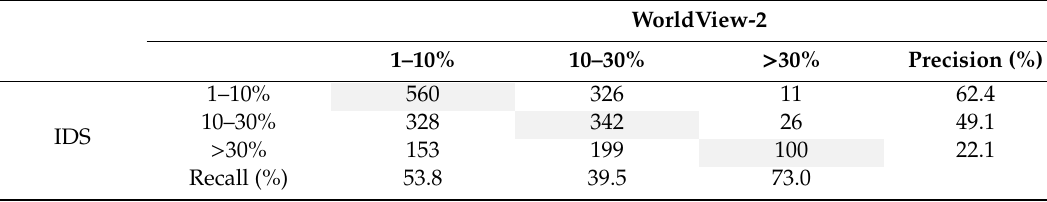
Table A4. Comparison of percent tree mortality area derived from 2018 WorldView-2 and IDS polygons (2014–2018 cumulative). IDS trees per acre measurements were converted to percent mortality using the Meddens method. Overall accuracy = 49.0%, N = 2045.